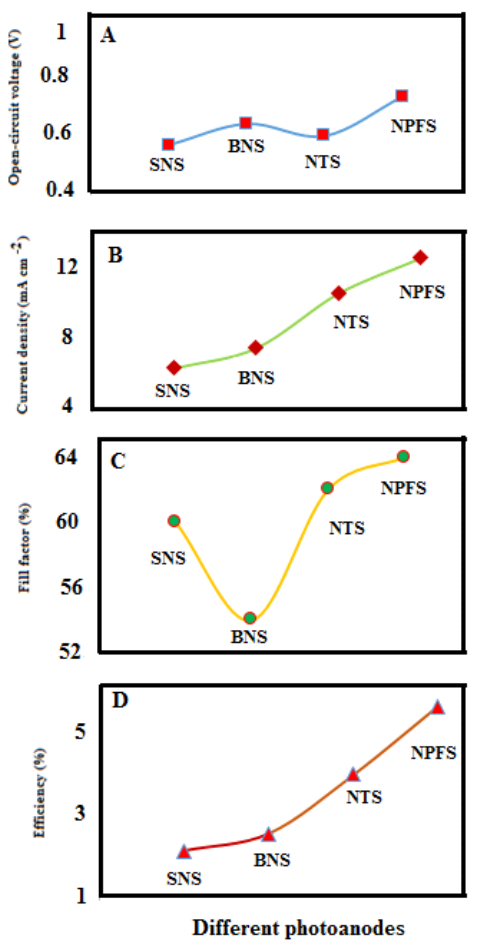
Fig. 6. Photovoltaic-characteristics relationship with different TiO photoanodes (A) V